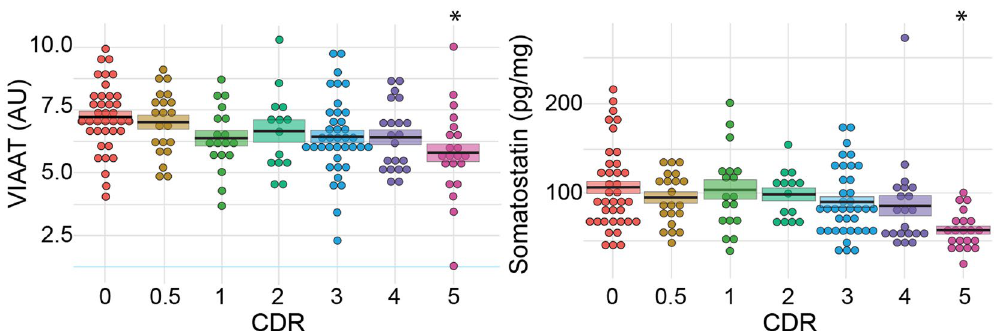
Figure 6. Dot plot representation of the effect of dementia on the expression of GABAergic markers. VIAAT expression levels were determined by western blots, and somatostatin was measured by radioimmunoassay. The results were plotted against the CDR scores. Each individual value is represented by one dot. Bold black lines represent the mean, and colour boxes represent the SEM. VIAAT and somatostatin expression were significantly reduced in subjects with CDR scores of 5 (p < 0.05). * p <